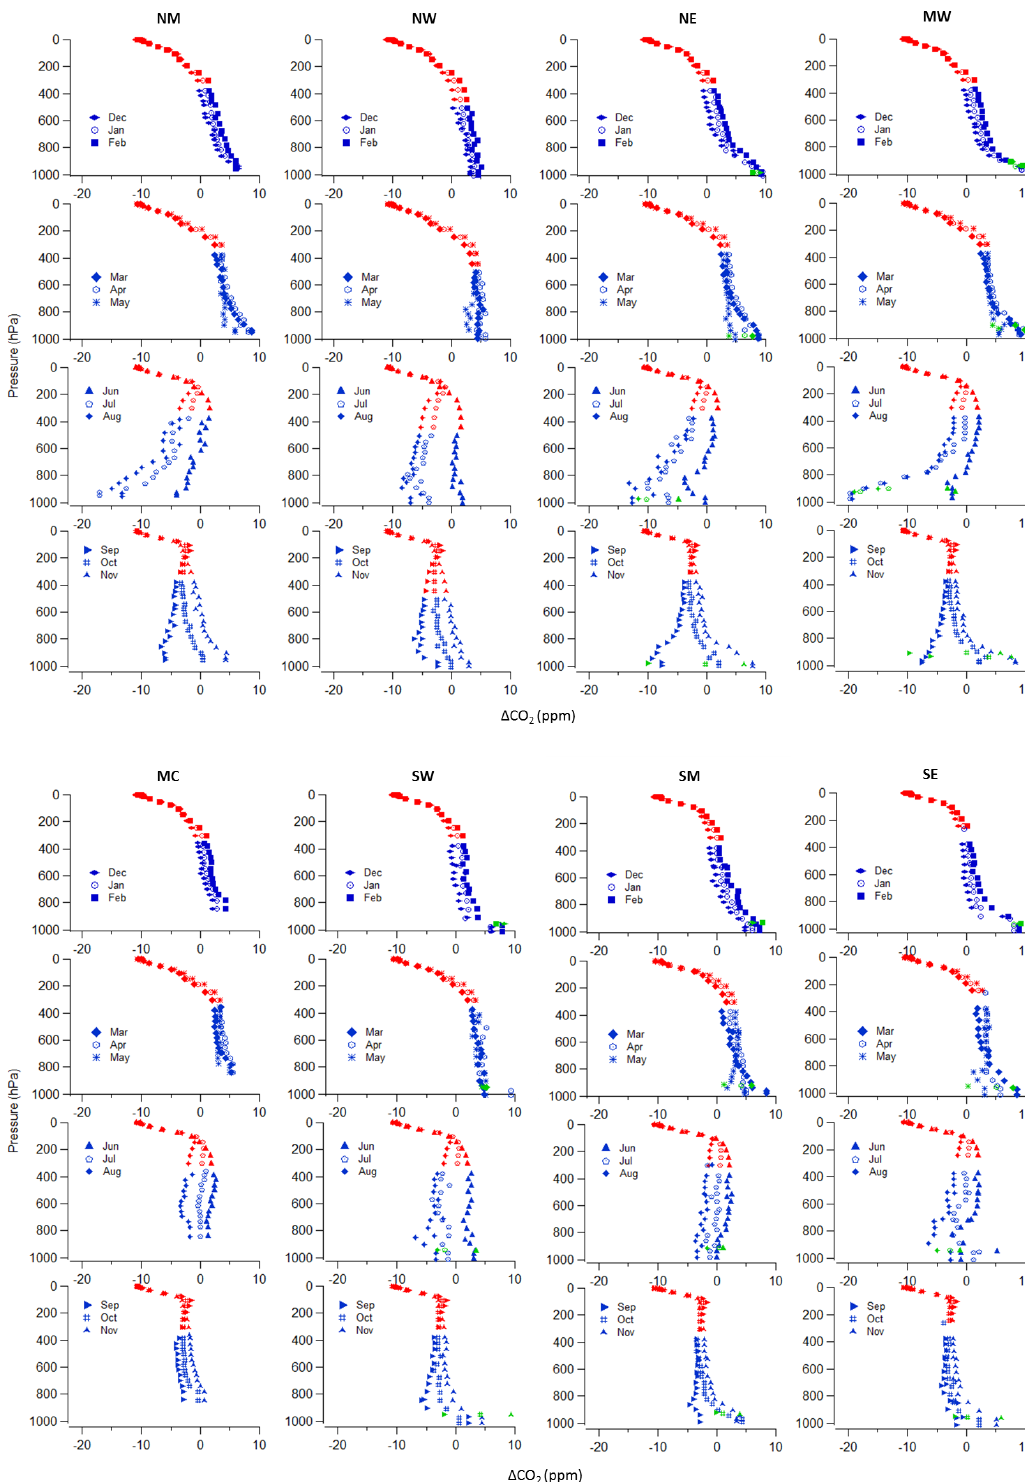
Figure 6. Long-term mean (2004–2014) monthly vertical profiles in NM, NW, NE, MW (by column, from left to right in the upper panel) and in MC, SW, SM, SE (by column, from left to right in the bottom panel). Blue points were calculated from observations, red points were calculated from CT2015, and green points were calculated from tower